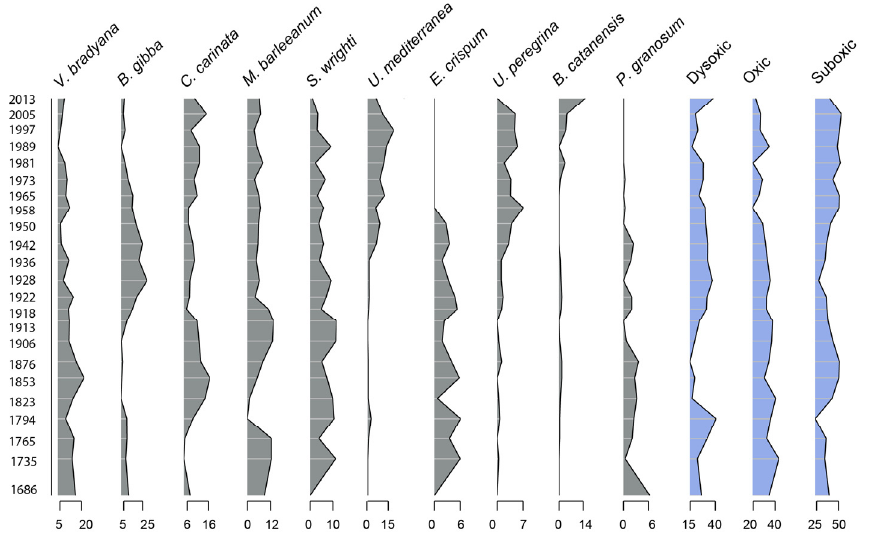
Figure 2. Temporal relative abundance variations of selected benthic foraminiferal species and oxic, dysoxic and suboxic groups. Note the horizontal scales (%) are not homogeneous.